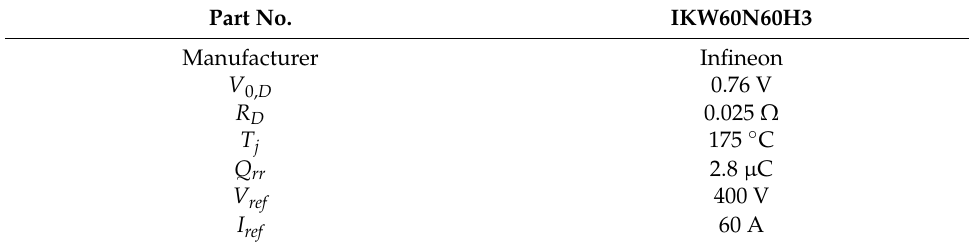
Table 3. Diode key parameters.